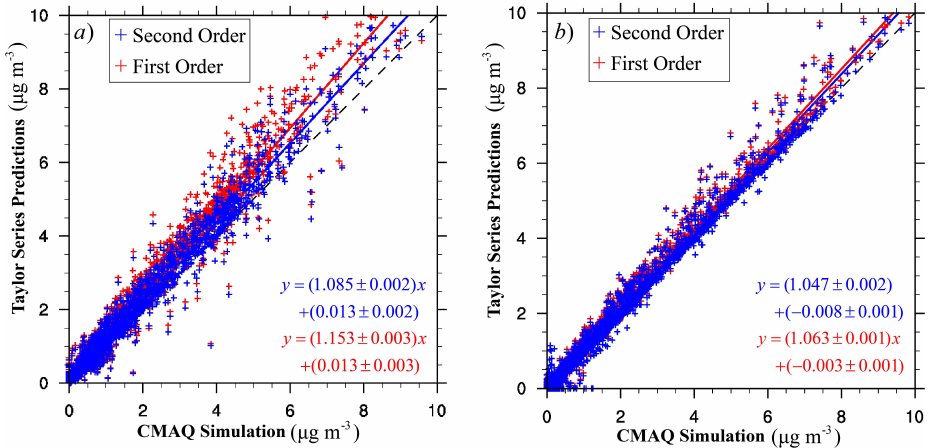
Fig. 8. Comparisons of model simulation and predictions using Taylor series expansions for concentrations of nitrate at 16:00 EDT on 2 January 2004, with (a) a 50% reduction in NO x and (b) a 50% reduction in SO 2 . The solid lines reflect the linear regression of the Taylor series predictions against the CMAQ simulation results; the dotted lines represent the area of perfect